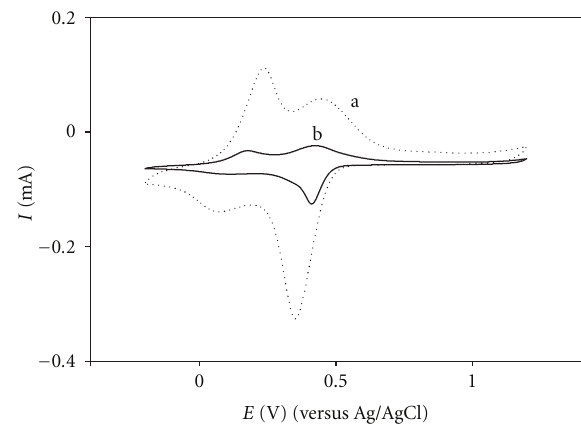
Figure 2: Cyclic voltammogramsof (a) PANI/gold nanorod and (b) PANI film at 100mV/s scan rate at +0.6V in stirred 0.1M sulphuric acid and 0.1M Na 2 SO 4